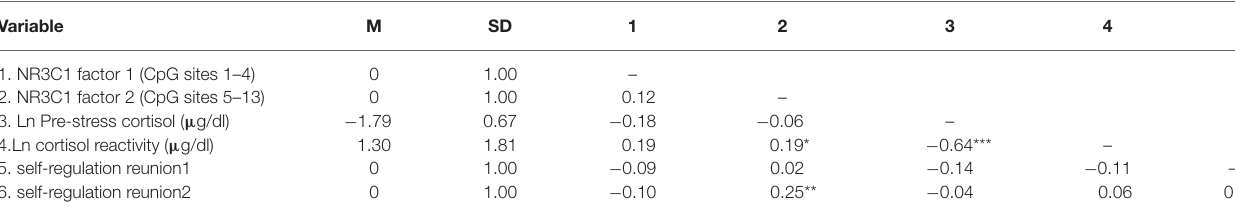
TABLE 1 | Means, standard deviations, and correlations of variables of interest . Variable M